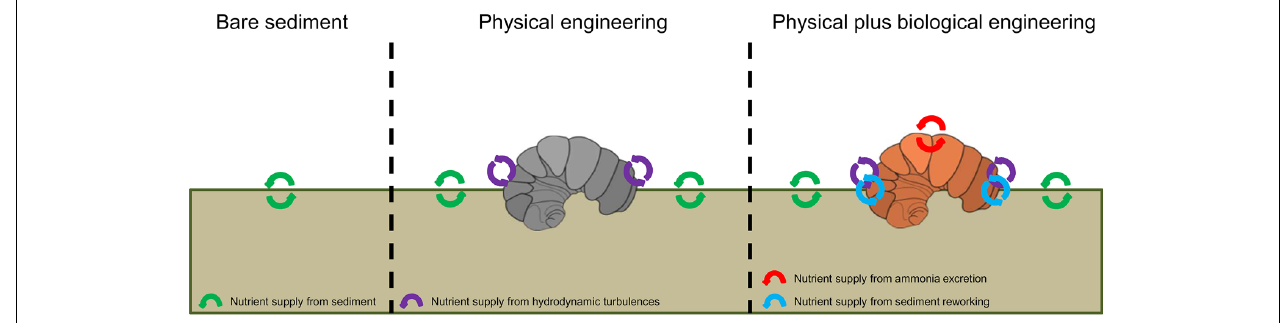
FIGURE 7 | Schematic diagram of the effects of C. fornicata on MPB growth, discriminating between the effects of dead (physical engineering) and live (physical plus biological engineering) animals.